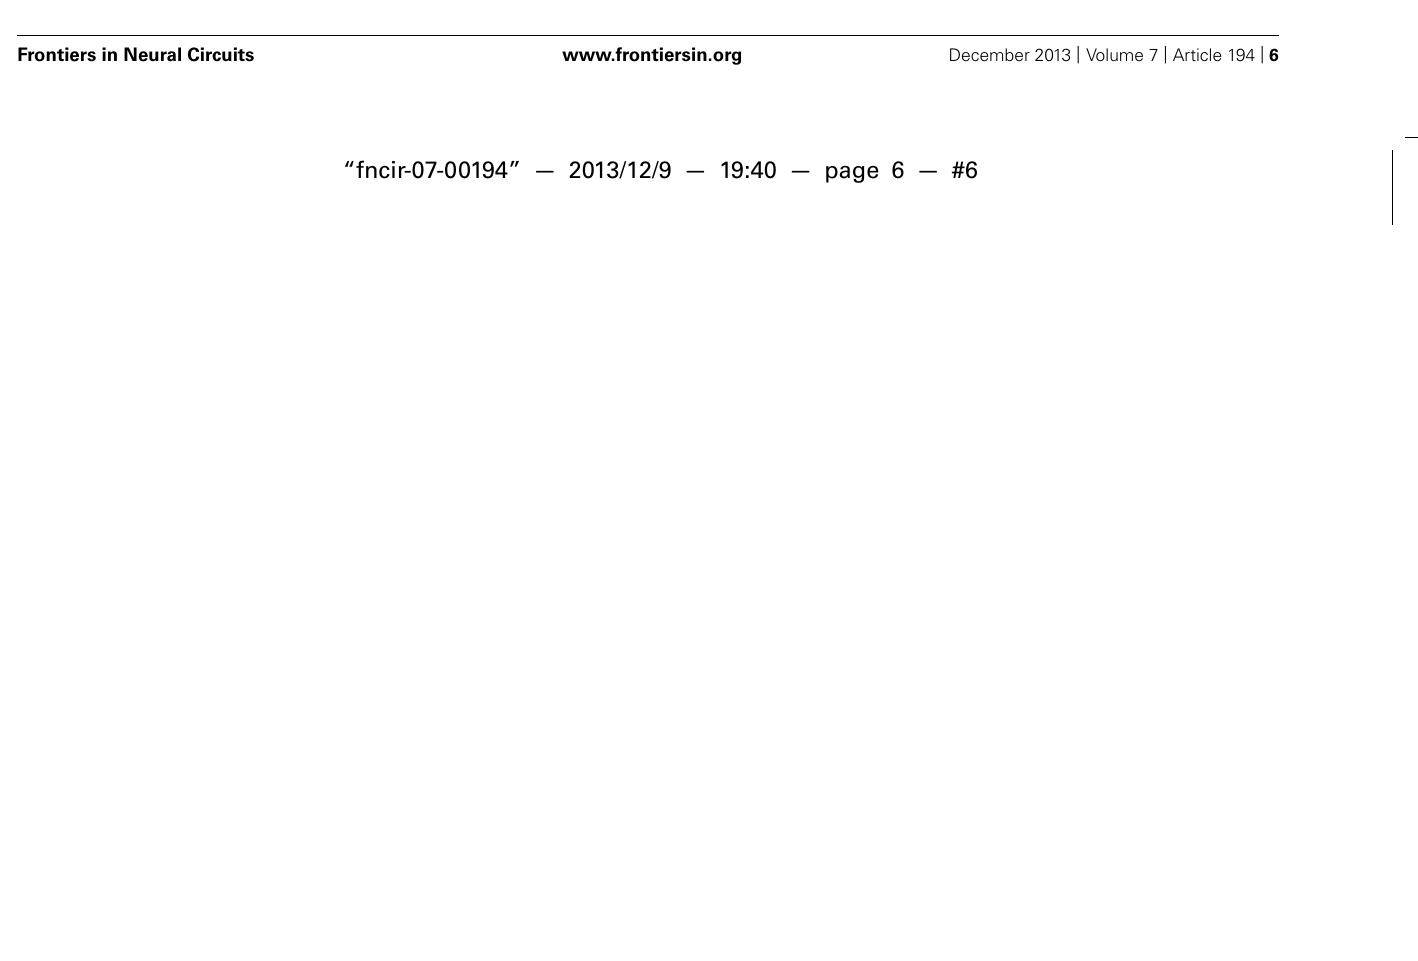
FIGURE 3 | Five generic modes in identical, identically pulse-coupled LIF oscillators with identical conduction delays. Pink shaded regions show relationship of delay to the phase, blue show the relationship to the time lags. (A) For a synchronous mode and identical oscillators with short delays, the stimulus interval t s in each oscillator is equal to the delay δ .The dashed lines show that the first spike in the top neuron does not affect the timing of the very next spike in the same neuron, but rather the one after that, so k = 2. (B) In the leader–follower mode for k = 1, the stimulus interval in the follower (top) is equal to the network period, the time lag between the firing of the leader and that of the follower is equal to the delay, and the stimulus interval